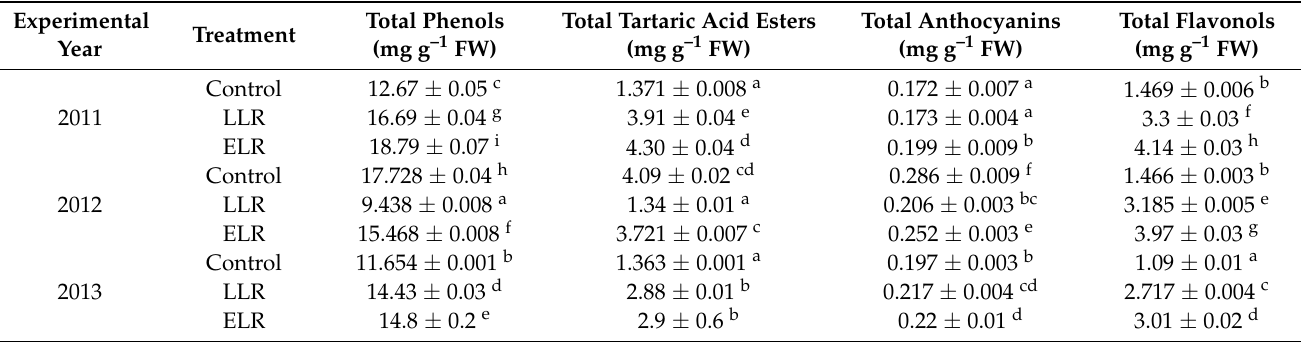
Figure 4. Effect of leaf removal and experimental year on the relative proportion of skin in a grape berry. Full model R 2 adj. 0.75, F = 10.7, p = 0.000019. Mean values marked with the same letter are not significantly different at α = 0.05. Vertical bars denote 95% confidence intervals. Table 3. Effects of leaf removal time and experimental year on the concentrations of total phenols, tartaric acid esters, and anthocyanins and flavanols in berry skin determined by HPLC. LLR, late leaf removal; ELR, early leaf removal. Data are means of three replicates ± sd. Different letters in a column denote significant differences among treatments according to Tukey’s test following a two-way ANOVA at α = 0.05.